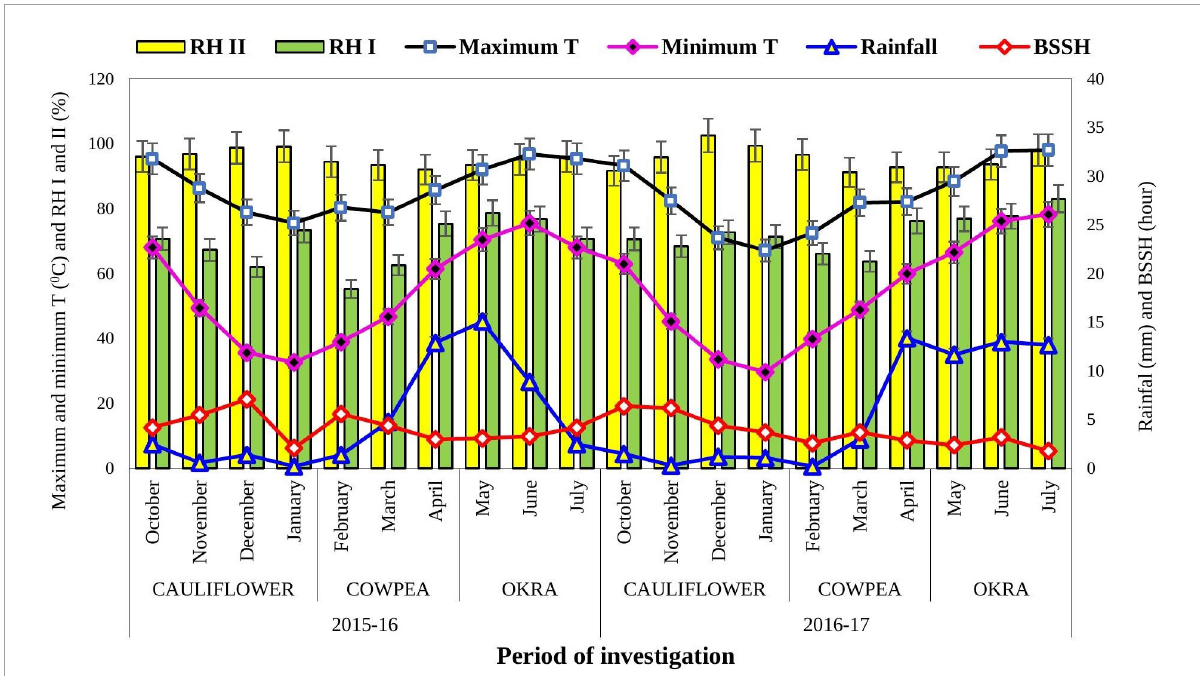
FIGURE1 Meteorological data during the period of investigation for the year 2015–2017. Source: Department of Agrometeorology, Assam Agricultural University, Jorhat, Assam. The vertical bars represent the SE(m) ± . T, temperature; RH, relative humidity; and BSSH, bright sunshine hour.